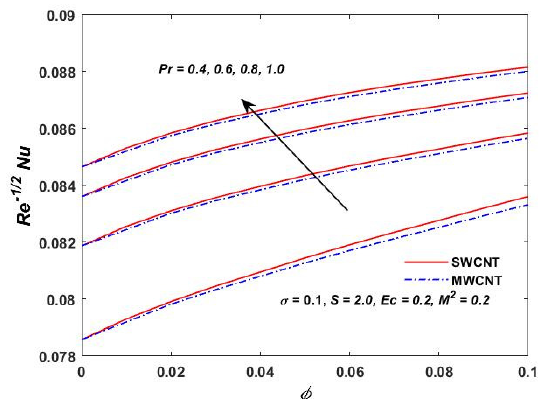
Figure 18. Prandtl verses Re − 1/2 Nu